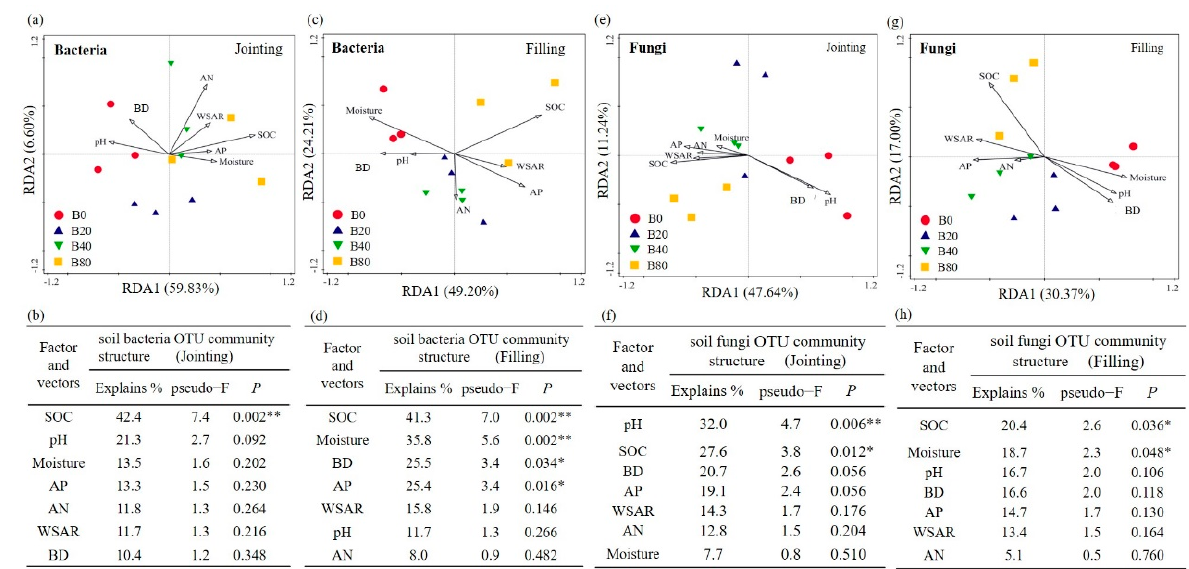
Figure 4. Ordination biplots based on the redundancy analysis (RDA) of bacterial and fungal community composition (dominant OTU level data) ( a , c , e , g ). The contribution and significance of different variables to the variation in the overall bacterial and fungal community composition ( b , d , f , h ) was tested by Monte Carlo permutations. * p < 0.05, ** p < 0.01. Note: BD: bulk density; WSAR: water-